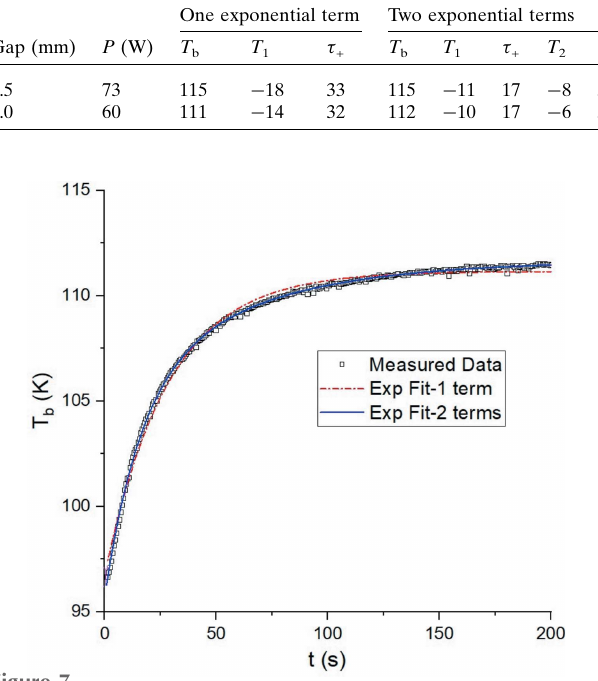
Figure 7 Temporal evolution of I16 crystal temperature for an undulator gap of 7.0 mm and S 1 size of 2.5 mm (cid:6) 1.0 mm. The red and blue lines are fit results with one and two exponential terms,